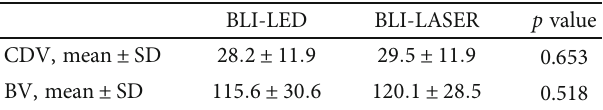
Table 3: The analysis of the CDV and BV for BLI-LED and